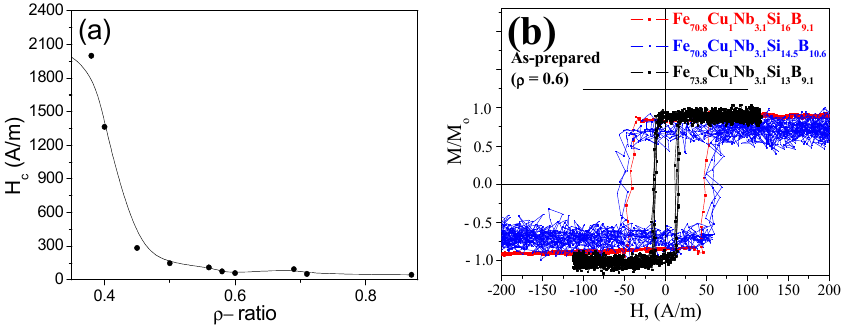
Figure 4. Coercive field dependence on ρ -ratio for as-prepared Fe 70.8 Cu 1 Nb 3.1 Si 16 B 9.1 glass-coated micorwires ( a ), hysteresis loops of as-prepared Fe 70.8 Cu 1 Nb 3.1 Si 16 B 9.1 , Fe 70.8 Cu 1 Nb 3.1 Si 14.5 B 10.6 , and Fe 73.8 Cu 1 Nb 3.1 Si 13 B 9.1 Finemet glass-coated microwires with the same ρ -ratio = 0.6 ( b ). Reproduced